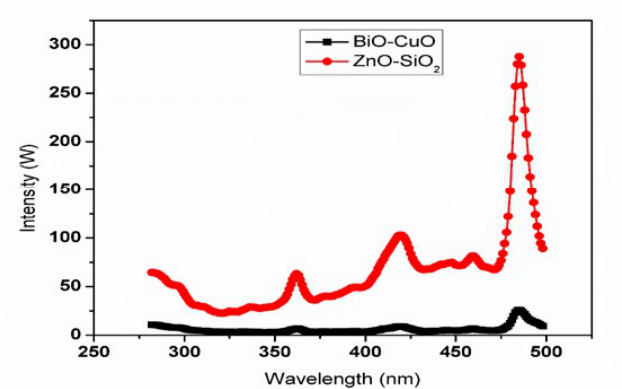
Fig. 9. PL spectra of the prepared nanocomposites Fig.